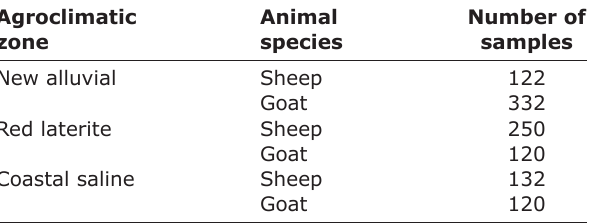
Figure-1: Study area- South Bengal (southern part of West Bengal state) depicted as green color. Table-1: Serum samples collected from different agro-climatic zones of West Bengal during July, 2010-December, 2013.